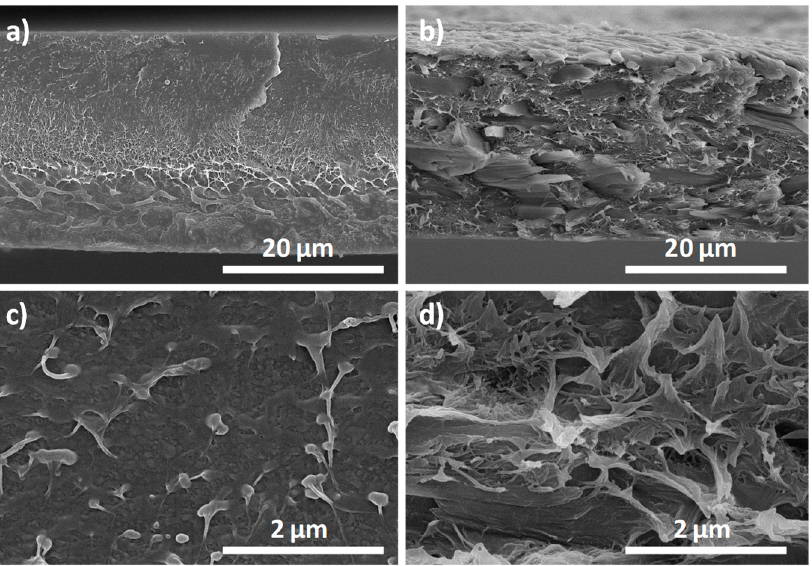
Figure 2. SEM micrographs of cryogenically fractured poly (vinylidene fluoride) (PVDF) ( a and c at higher magnification) and PVDF/CNC 10 wt.% nanocomposite surfaces ( b and d at higher magnification).